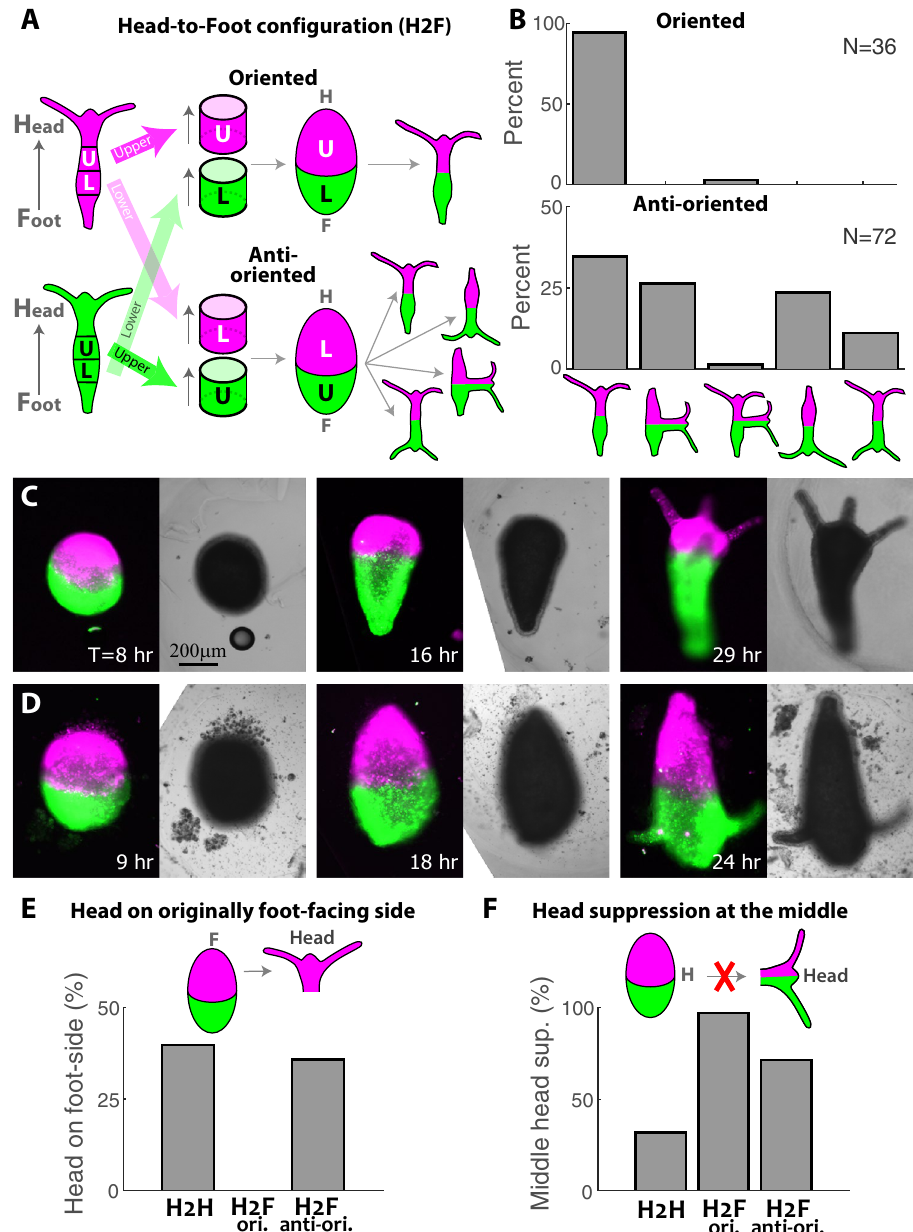
Figure 2. Regeneration of Head-to-Foot (H2F) ring doublets depends on the position of the excised rings within the parent animals. ( A ) Schematic illustration of the regeneration experiments with fused ring doublets in the H2F configuration. Rings are excised from above (U) or below (L) the approximated midpoint of the two parent animals that are differentially labeled (green/ magenta). The rings are fused so that the head-facing side of the first ring adheres to the foot-facing side of the second ring in an oriented configuration that preserves the relative position of the rings (top) or an anti-oriented manner (bottom). ( B ) Bar plot depicting the outcome morphologies of fused ring doublets generated in the H2F configuration in an oriented (top) or anti-oriented manner (bottom). Experiments were performed on 37 oriented ring doublet samples and 78 anti-oriented samples. In the oriented samples 1/37 disintegrated and 36/37 regenerated, out of which 34 regenerating along the original polarity. In the anti-oriented no samples disintegrated, 6/78 did not regenerate, and 72/78 regenerated into one of several possible outcome morphologies: a normal morphology along the original polarity, a head in the middle, a head in the middle and at the oral edge, a normal morphology with flipped polarity, two heads at the oral and aboral edges (“Methods”). All but 2/78 (i.e. 97%) of the regenerated animals fell into one of these categories. The percentages of regenerated animals in each category are depicted. ( C ) Images from a time lapse movie of an oriented H2F doublet that regenerated into a normal animal along the original body axis orientation (Movie 3). ( D ) Images from a time lapse movie of an anti-oriented H2F doublet that regenerated into an animal whose body axis is oriented in the opposite direction to its original polarity, with a head forming on the original foot-facing side (Movie 4). The panels in ( C , D ) depict combined epifluorescence (left; green- AlexaFluor 647-conjugated 10kD dextran, magenta- Texas Red-conjugated 3kD dextran) and bright- field (right) images at the specified time points during the regeneration. ( E ) Bar plot summarizing the incidence of head formation on an originally foot-facing edge (polarity reversal) in regenerating ring doublets in the H2H and H2F oriented and anti-oriented configurations. ( F ) Bar plot summarizing the incidence of head suppression at an originally oral ring interface in the middle of regenerating ring doublets in the different configurations. The data in ( E , F ) is based on Figs. 1B and